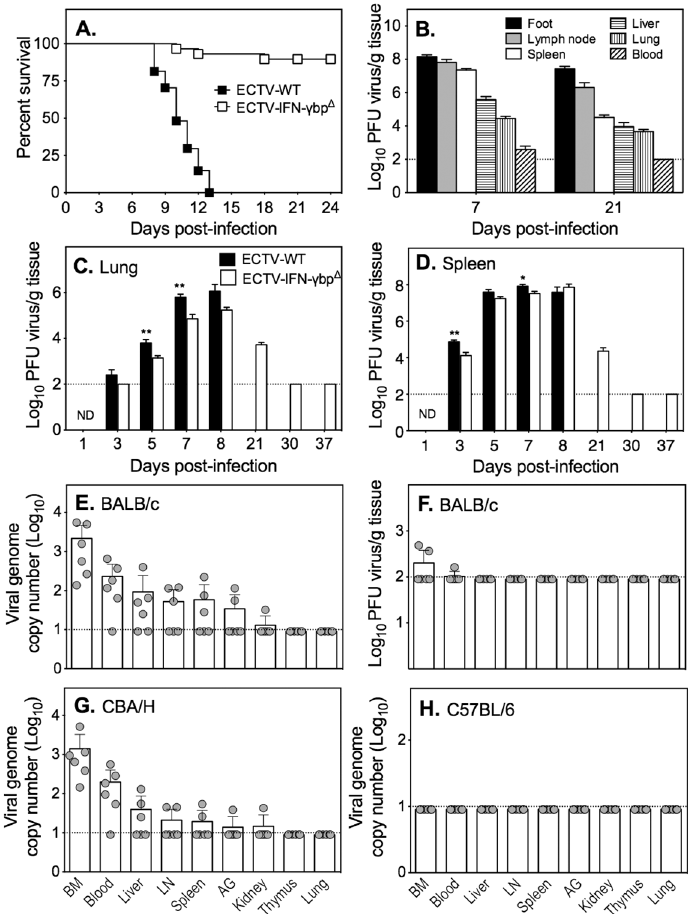
Fig 1. Presence of ECTV-IFN- γ bp Δ in mice that survive infection. (A) Survival proportions of BALB/c mice infected with 500 PFU ECTV-WT (n = 27) or ECTV-IFN- γ bp Δ (n = 58). P < 0.0001, Kaplan-Meir log rank statistical test. Survival data combined from 4 separate experiments, with 6 – 15 mice per experiment. (B) ECTV-IFN- γ bp Δ titers in the indicated organs of BALB/c mice at days 7 and 21 p.i. (C) Lung and (D) spleen titers of ECTV-WT and ECTV-IFN- γ bp Δ . * , P < 0.05; ** , P < 0.01 in comparing ECTV-WT and ECTV-IFN- γ bp Δ titers at the days p.i. Data shown in (B), (C) and (D) are composite viral loads determined in individual animals from 3 different experiments with groups of 3 – 6 mice and expressed as means of log 10 PFU/gram tissue ± SEM. The limit of virus detection is 2 log 10 PFU, shown by the dotted line. (E) ECTV genomes and (F) infectious virus in organs of BALB/c mice 37 days p.i. with ECTV-IFN- γ bp Δ . (G) ECTV genomes in organs of CBA/H mice 37 days p.i. with 500 PFU of ECTV-IFN- γ bp Δ . (H) ECTV genomes in organs of C57BL/6 mice 37 days p.i. with 500 PFU of ECTV-IFN- γ bp Δ . For E, F, G and H, n = 5 mice. The limit of virus genome detection is 10 copies, shown by the dotted line. BM = bone marrow; LN = popliteal lymph node; AG = adrenal gland.